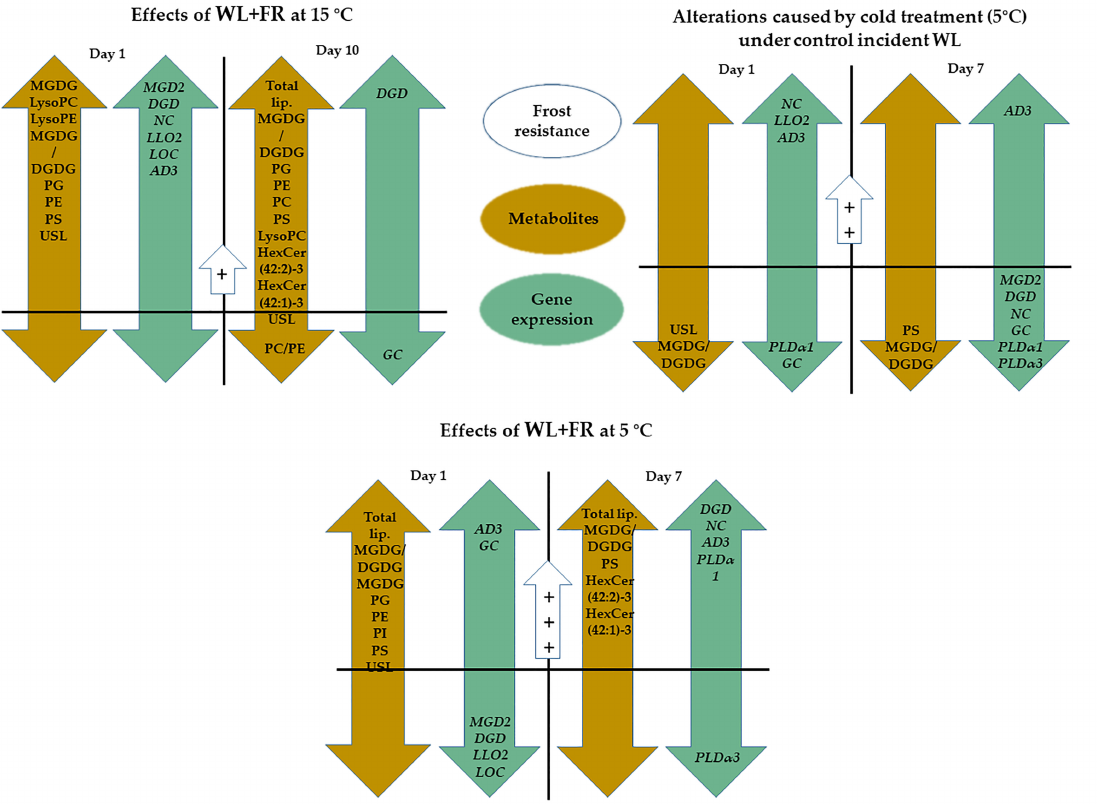
Figure 7. Our conclusion about the e ff ect of WL-enriched FR and cold temperature on lipid content and quality of the expression of the related genes in barley leaves. Lipid composition changes under WL + FR: LysoPC, LyoPE, PC, PG, PE, PS. Lipid composition changes elicited by cold temperature: Total lipid, PI. The PC / PE lipid ratio decreased under WL + FR. Gene expression changes under WL + FR: NC, DGD1, GC . Gene expression changes elicited by cold temperature: GC, NC, AD3, PLD α 1, PLD α 3 . Gene expression changes elicited by both cold temperature and WL + FR: GC, NC . The decrease in LLO2 and LOC gene expression positively influences membrane integrity after the cold acclimation period [71–74]. Symbols: Orange: Lipid metabolite changes; Green: Gene expression patterns; Blue: Frost resistance changes; The order of the induced frost tolerance: + < ++ < +++ . The significance level in figures is p <